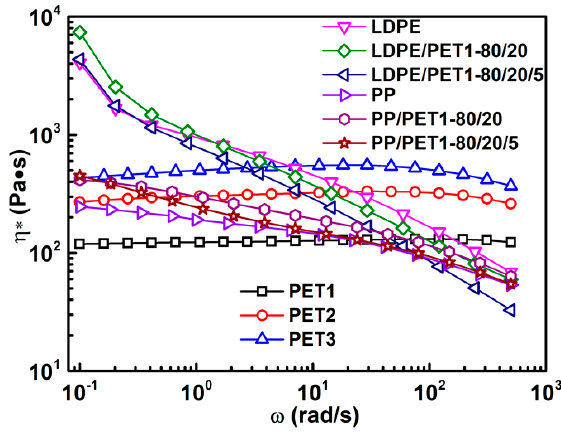
Figure 5. Complex viscosity for polymers and polymer blends.